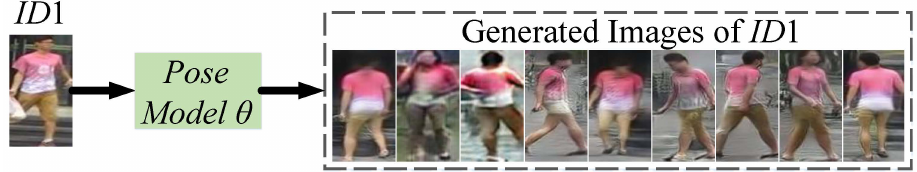
Figure 3. A Few Generated images of ID1 During training. Images are Generated using Pose Model θ